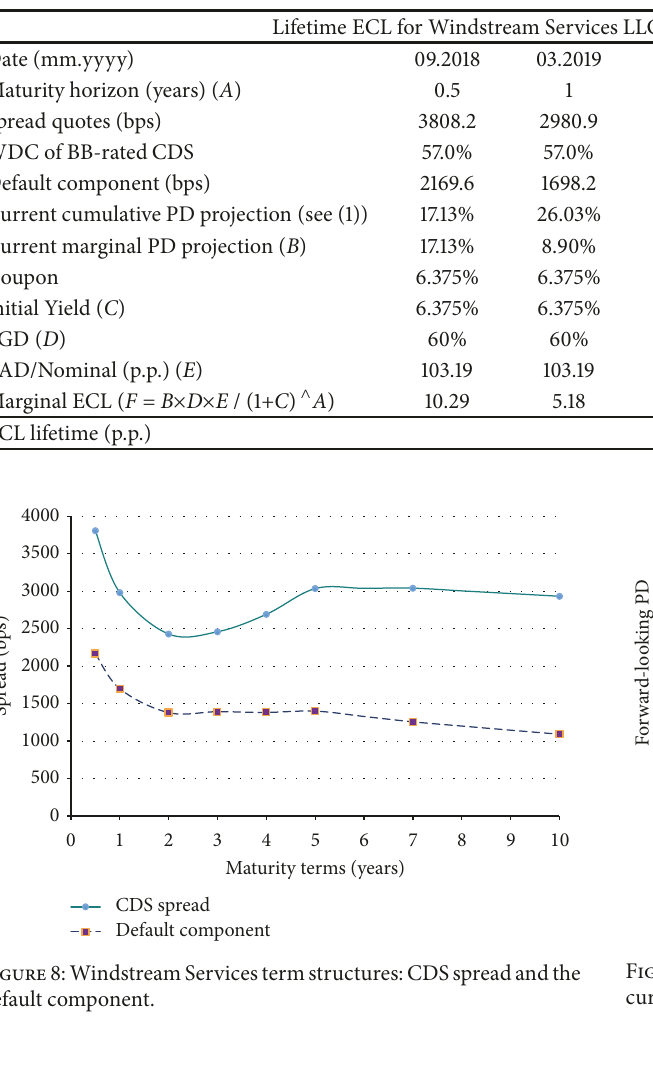
Table 4: Lifetime ECL for the bond of the Windstream Services as of March 30, 2018.